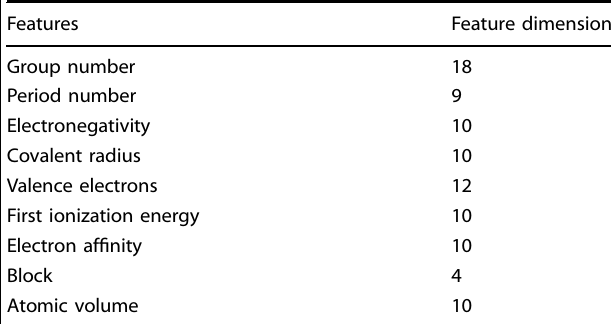
Table 1. Description of different atomic properties used as node features and their